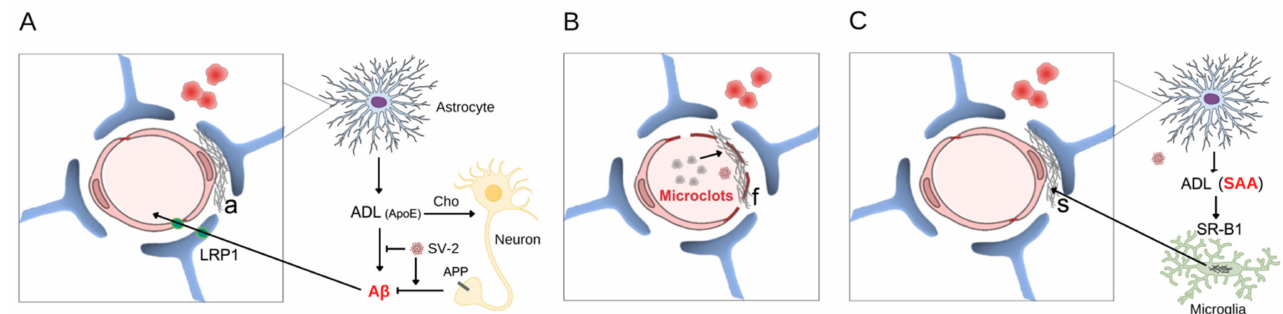
Figure 1. Vascular amyloid deposition induced by SARS-CoV-2. The intimate relationship between the endothelial cell (pink) and astrocyte feet (blue) that envelop the endothelial surface is indicated in the 3 panels. The stains (in red) next to the vessel, in all panels, represent microbleeds and emphasize that, in addition to the ischemic event caused by the amyloid deposit, a hemorrhagic event is associated with vascular fragility. In panel ( A ), a neuron is represented (yellow) with a membrane amyloid precursor protein (APP) and its amyloid peptide fragments (A β ). The production of astrocyte-derived lipoprotein (ADL), containing ApoE, which is involved in cholesterol (Cho) transport and A β clearance, is shown, as well as the membrane transporter for A β (LRP1) in the astrocyte and endothelium. With virus-induced dysfunction, there is an accumulation of amyloid (a) between the astrocyte and the endothelium. In panel ( B ), the amyloid microclots of fibrin and the fibrinoid deposition (f) on the vascular surface are represented. In ( C ), the non-A β amyloid deposit of SAA (s) is represented, where SAA comes from the periphery and from the astrocyte (via ADL), which initially undergoes fibrillogenesis in macrophages (microglia in the CNS are in green). SV-2 =